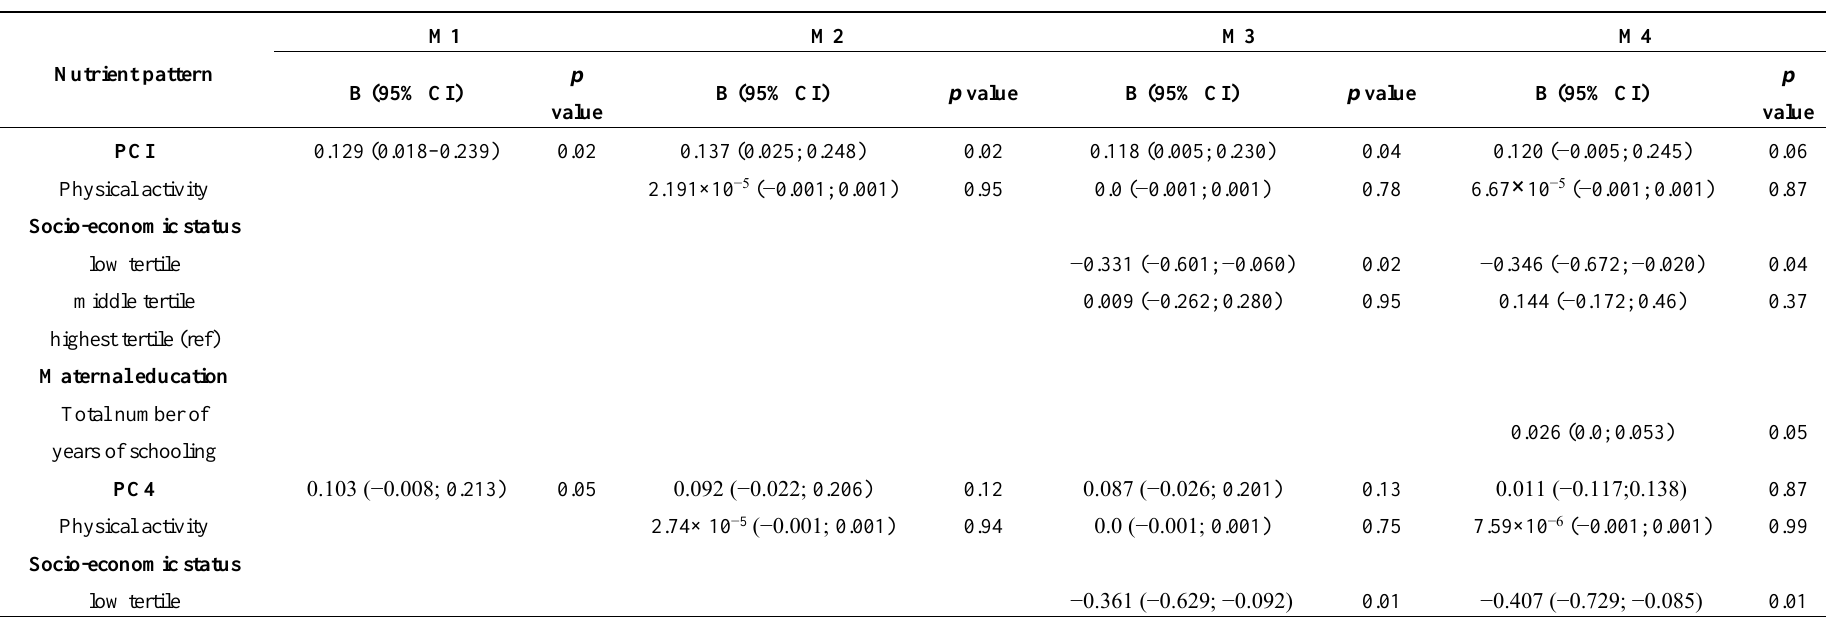
Table 4. Regression coefficients for BMI for Age Z scores for 1 SD increase in PC 1 ( Animal driven nutrients ) and PC4 (Starch and folate driven) scores in rural black South African